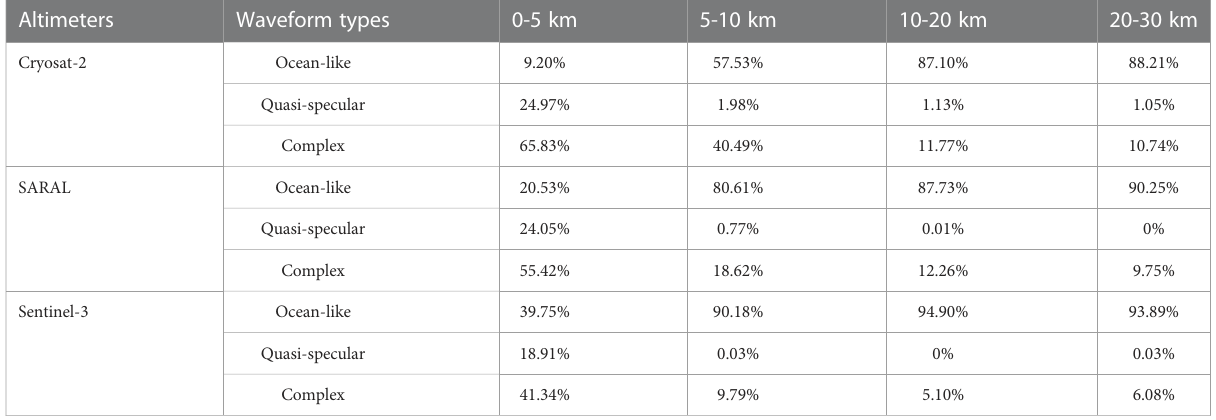
TABLE 4 Percentage of different coastal waveforms in the 0-30 km for three altimeters.